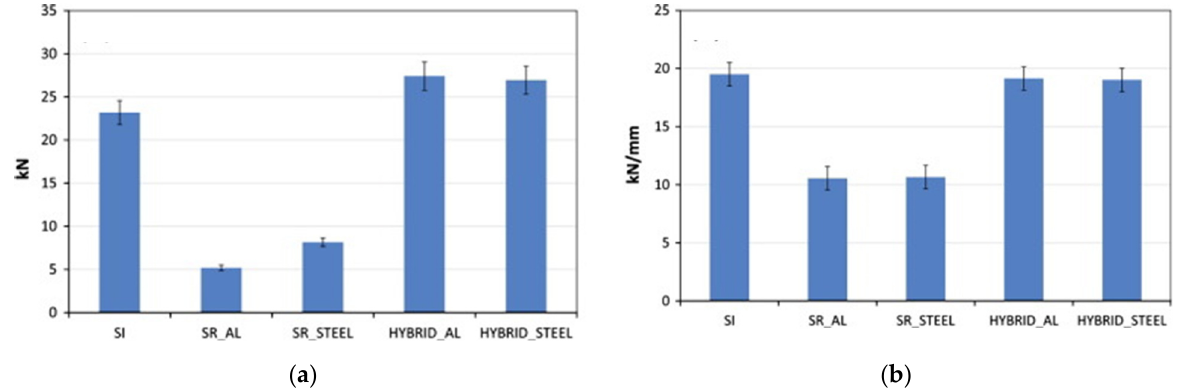
Figure 7. ( a ) Average tensile failure load and ( b ) average stiffness of the joints analyzed. Numerical experimental analysis of hybrid double lap aluminum ‐ CFRP joints [75].